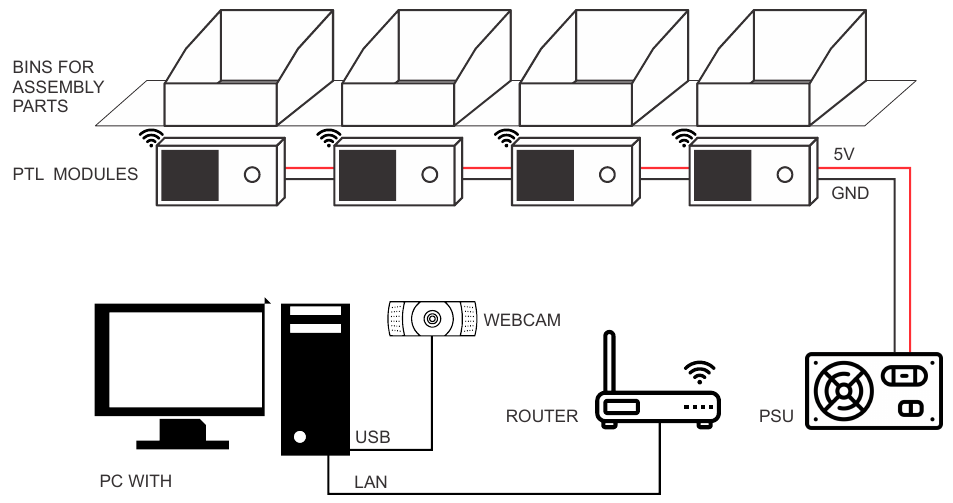
Figure 1. System architecture.